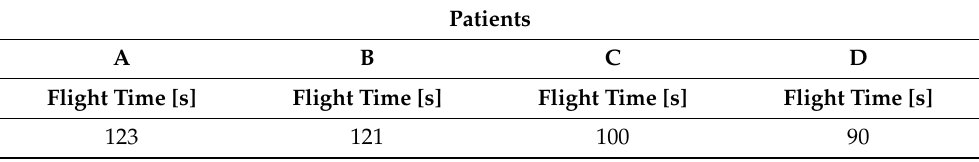
Table 9. Results of the patients’ flight times in the preliminary outdoor experiment.